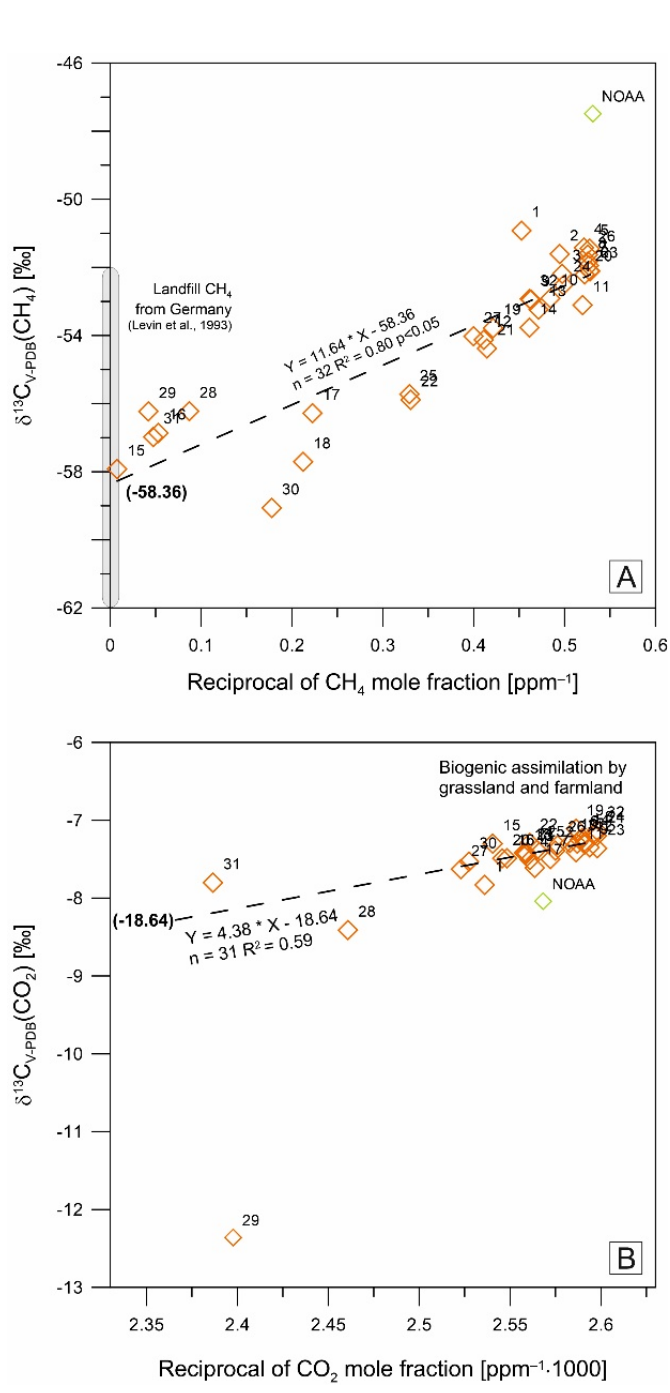
Figure 6. Relations between reciprocal of mole fraction and carbon isotopes composition of methane ( A ) and carbon dioxide ( B ) from ambient air gathered in the vicinity of municipal waste landfill sampled on 22 August 2017 campaign. Dashed lines show the linear regression fit of the data sampled. The green dots represent average background values according to Mace Head Research Station, Ireland, NOAA.